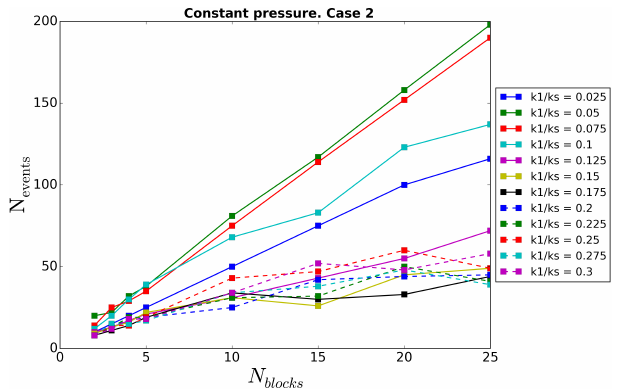
Figure 10. Maximum seismic moment vs. number of